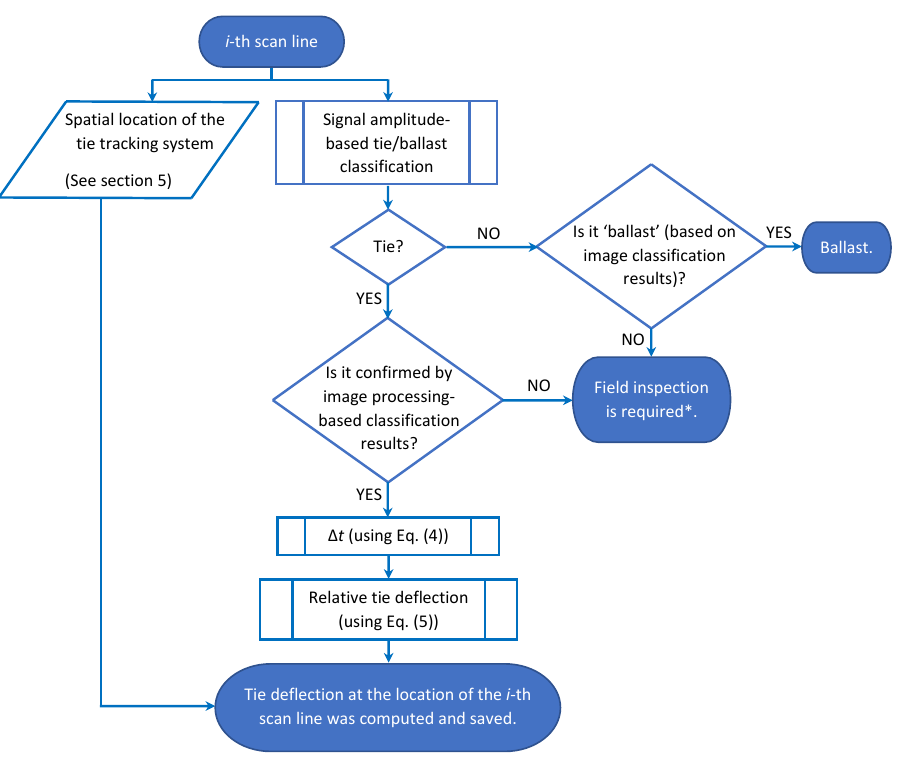
Figure 14. Flowchart of the proposed technique to track and compute the tie deflection at the location of the i -th scan line. ∗ If the algorithm converges to this state, a field inspection is required to confirm the condition. Misalignment between the tie and the probing beam or misplacement of ballasts on top of a tie (in the camera’s ROI) can be some of the possible conditions.